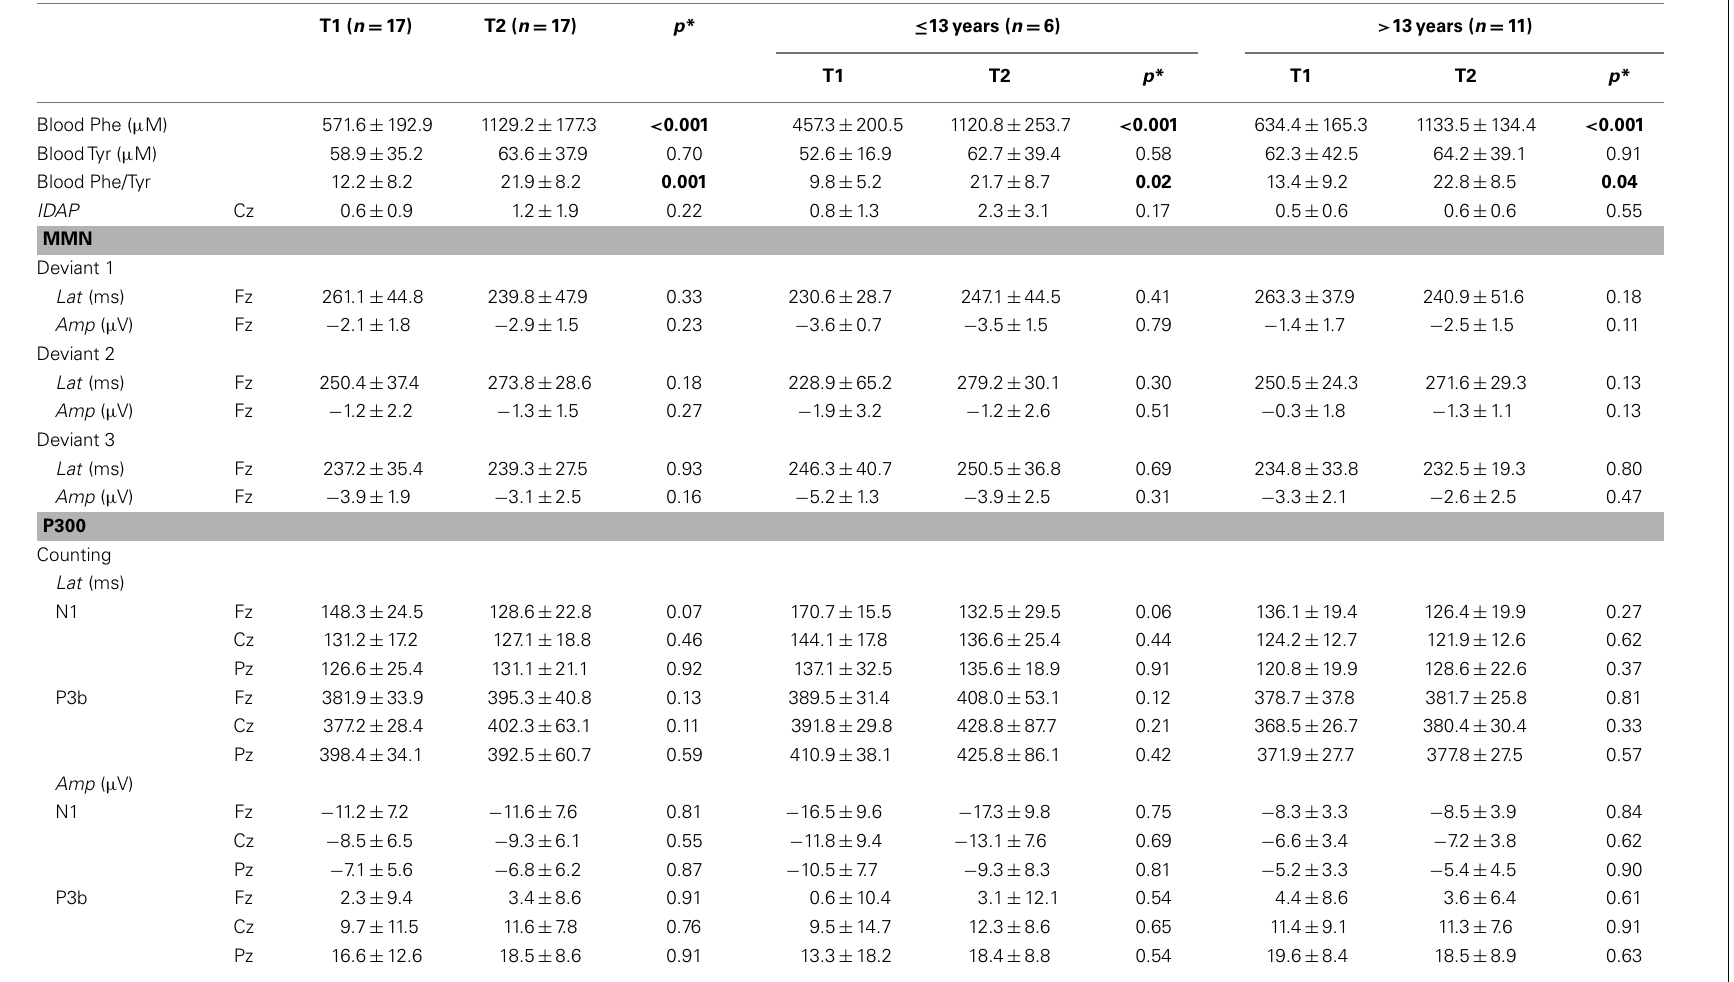
Table 4 | Means and standard deviations of biochemical parameters and ERPs values in PKU subjects